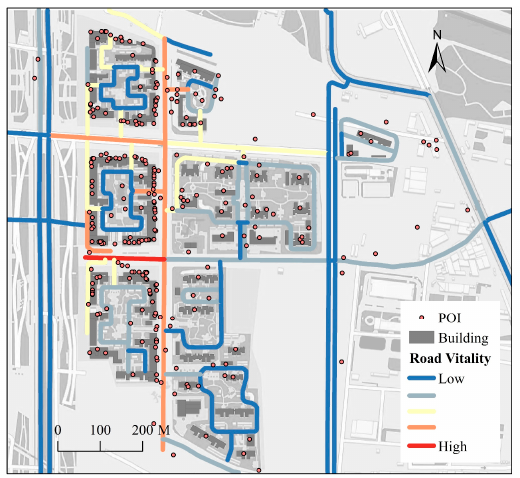
Figure 6. The road vitality of the Jinghu community.